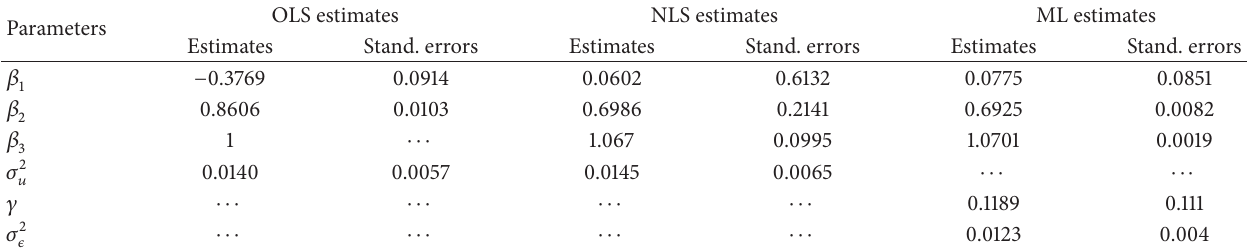
Table 4: Ordinary least squares, nonlinear least squares, and maximum likelihood with MA(1) errors.